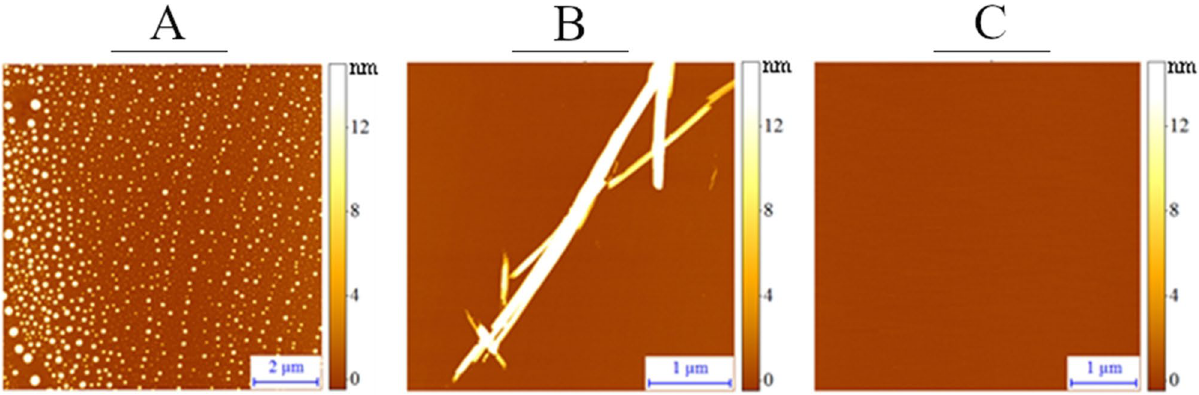
Figure 5. Representative AFM micrographs: ( A ) oligomer (FTFIQF), ( B ) amyloid (LVFYQQ), C. non-amyloid